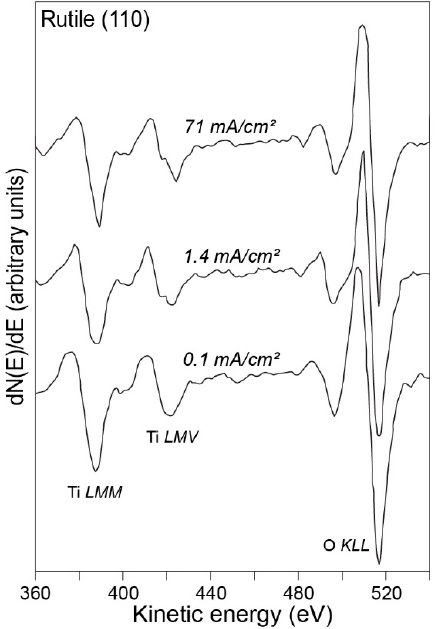
Figure 2. An Auger electron spectroscopy (AES) spectrum, for rutile TiO 2 single crystal at different primary electron beam intensities. Figure adapted with permission from [39].